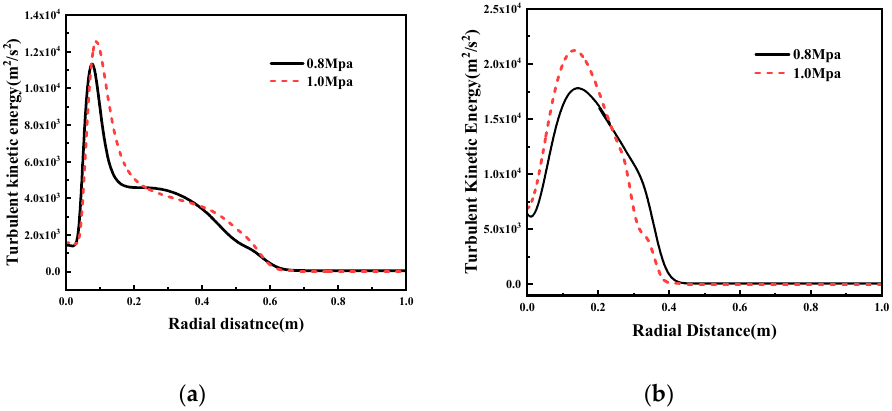
Figure 11. Comparison of nozzle exit temperature between Laval and cyclone oxygen lances under the same parameters: ( a ) nozzle exit temperature of Laval oxygen lance; ( b ) nozzle exit temperature of Cyclone oxygen lance.